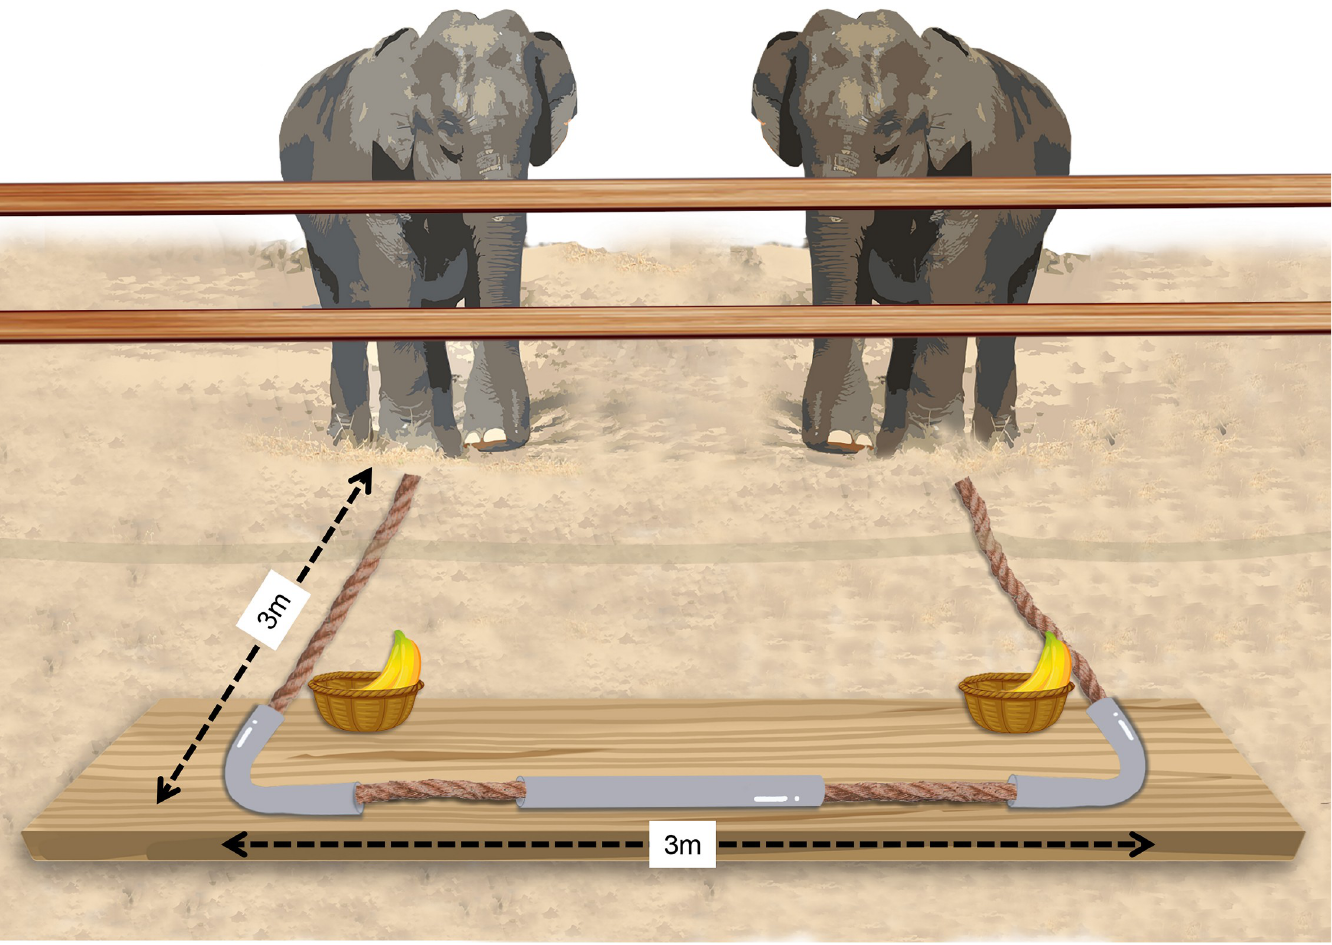
Fig 6. The loose-string cooperation apparatus in this